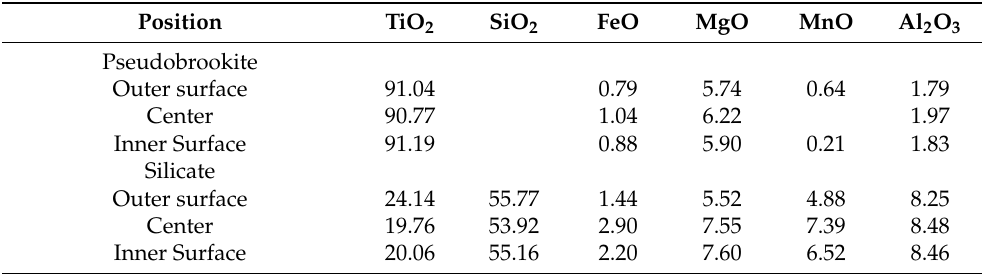
Table 4. Average composition of different regions in the slag sample 7 obtained with energy dispersive X-ray microscopy